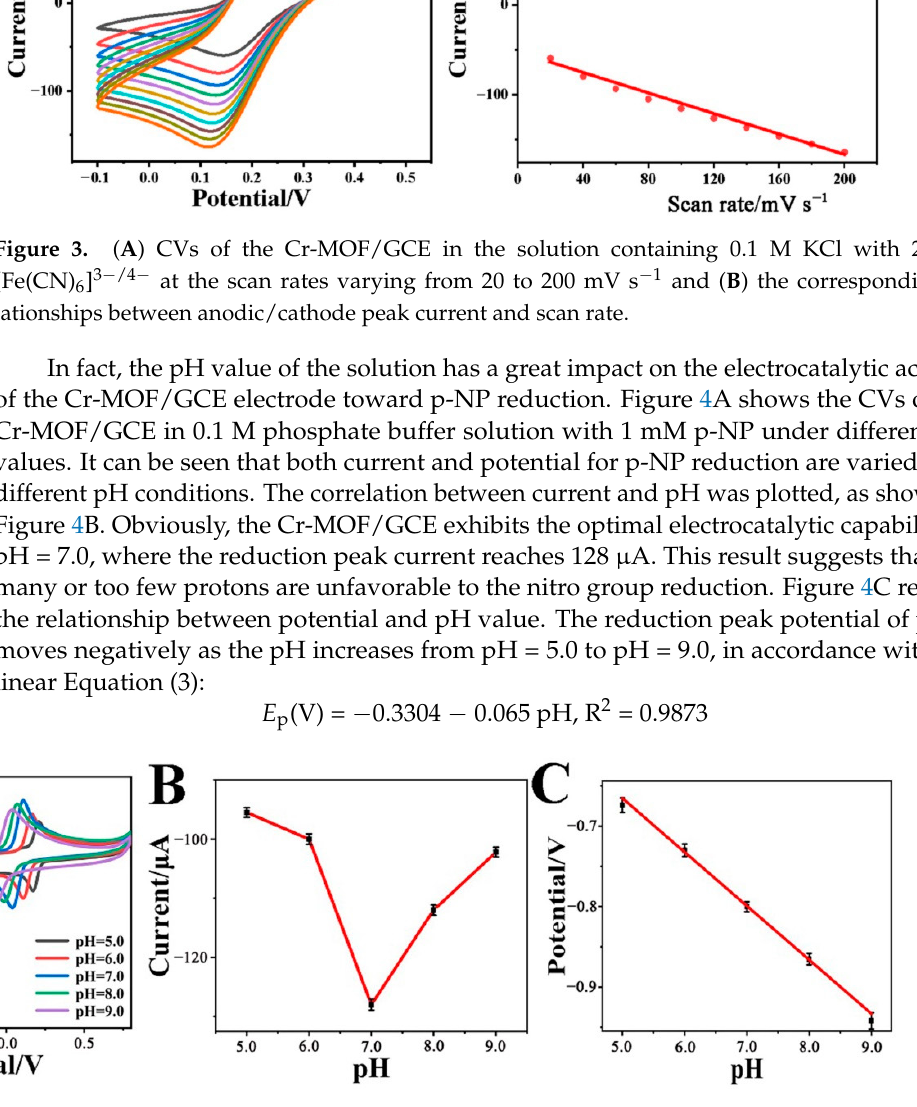
Figure 5. The possible mechanism of p-nitrophenol reduction in this system.